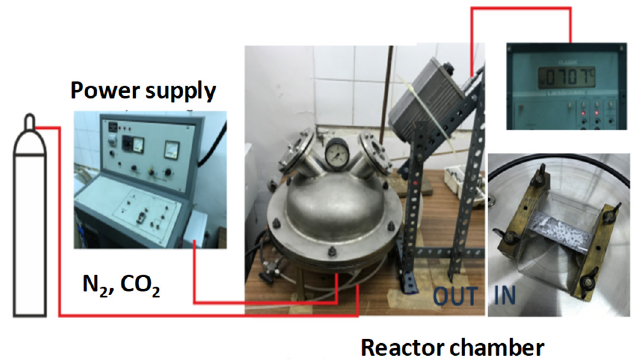
Figure 1. Heated Strip Reactor (HSR).